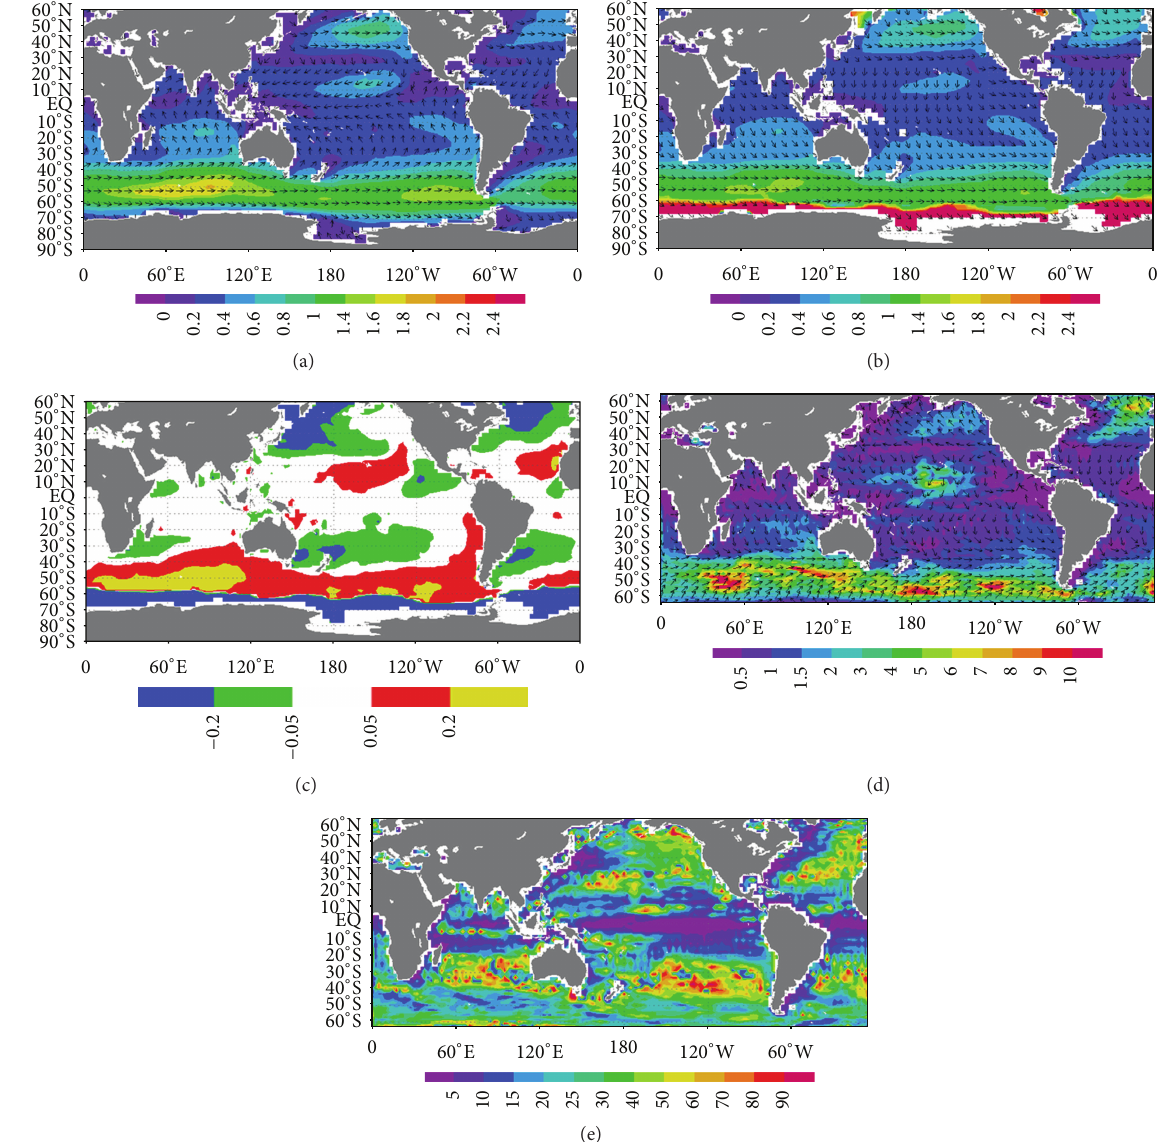
󳨀⇀ 2 s −1 ), simulated by WW3 model; (b) annual-mean 𝑇 𝑠 (m